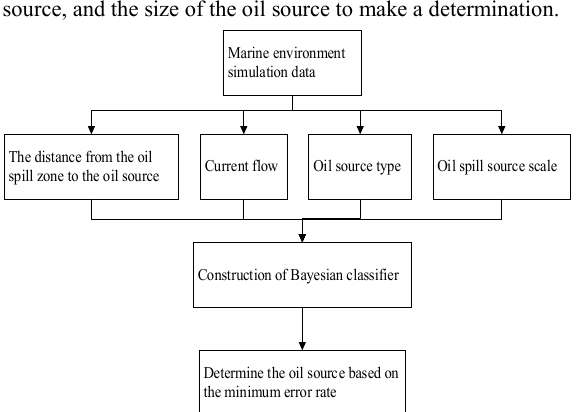
Figure 2. Flow chart to classify by using the simulation